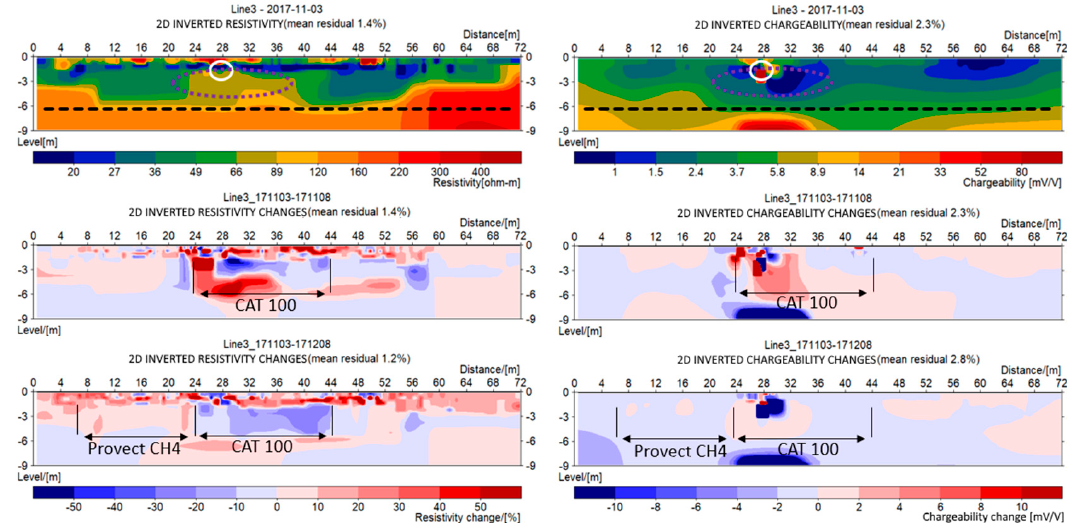
Figure 9. DCIP results from Line 3 baseline measurements 3rd of November 2017 (top) and time lapse changes between ( left ) the baseline and during the first injection 8th of November 2017 (middle) ( right ) the baseline and after second injection 8th of Deceber 2017 (bottom). Resistivity results are shown on the left and chargeability on the right. The purple dashed line indicates the contamination plume based on the joint interpratation of the conceptual model and the geophysical result.